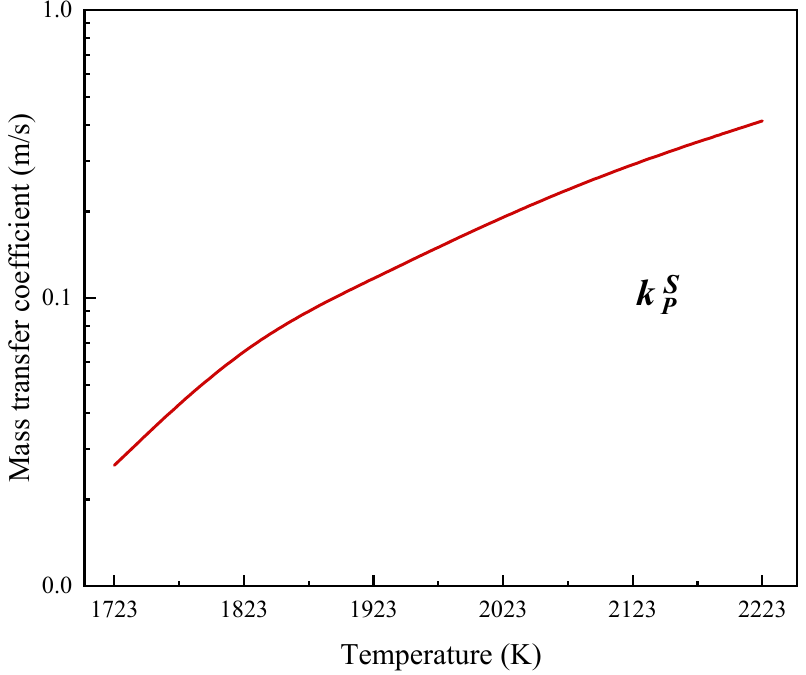
Figure 3. The effect of temperature on the mass transfer coefficient of phosphorus when evaporation occurs from the melt surface.